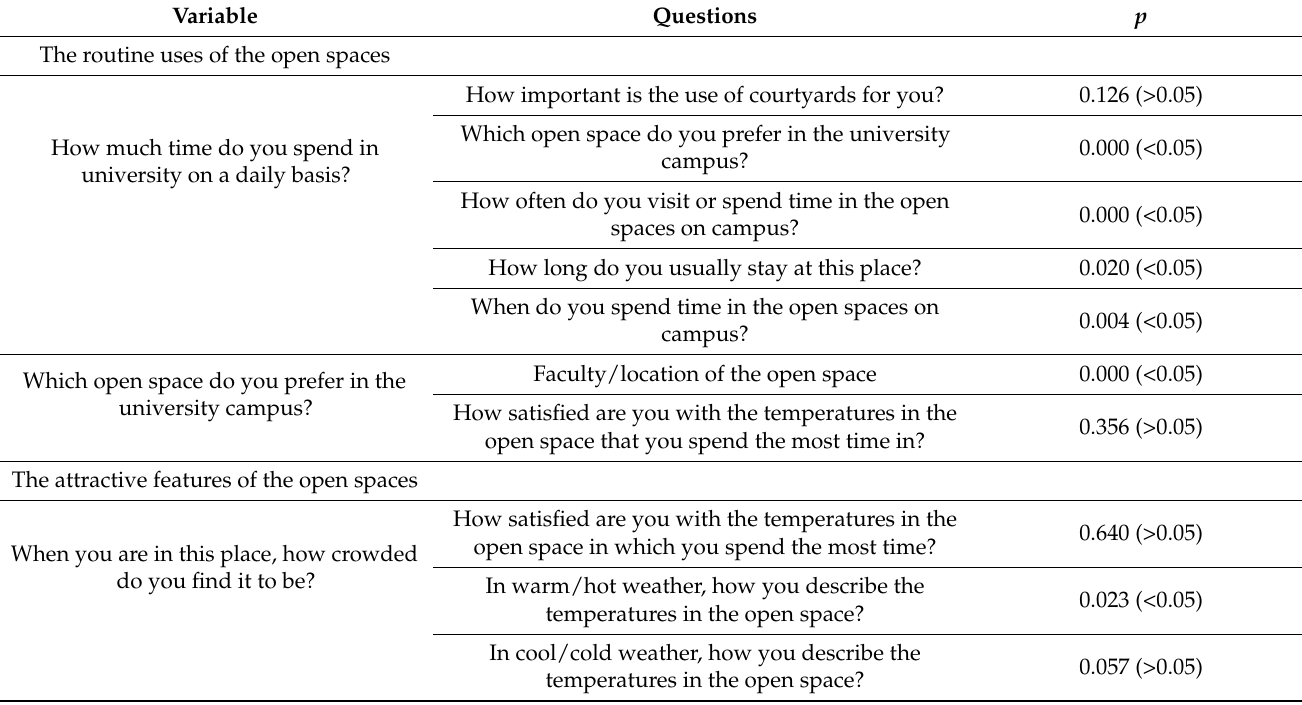
Table A2. Chi-square correlation matrix between main variables of the